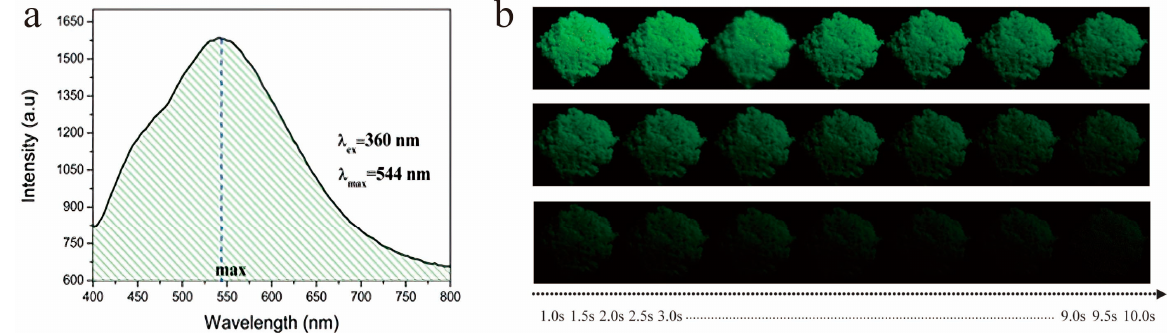
Figure 3. Phosphorescent spectra ( a ) and photos of light intensity over time ( b ) of RTPL materials.